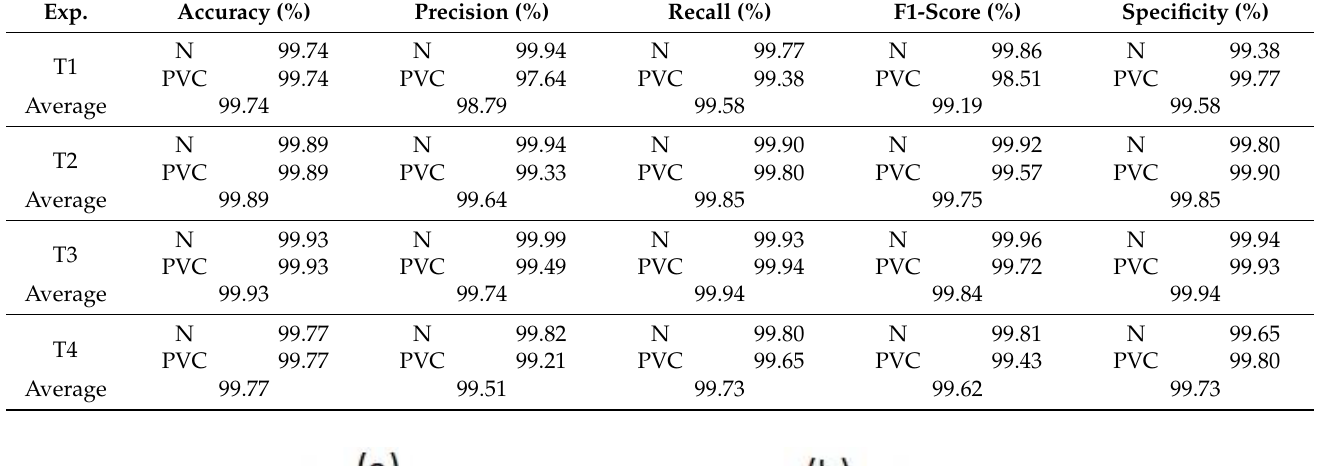
Table 3. A summary of achieved metrics in all the experiments from the confusion matrix. Exp.